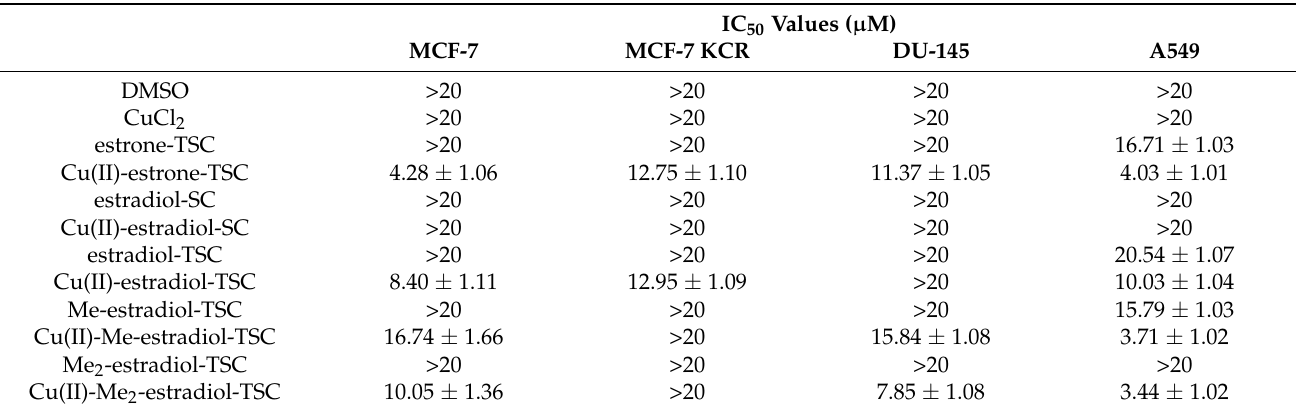
Table 7. IC 50 values ( µ M) of the complexes and the ligands determined on various cancer cell lines. (24 h incubation time).